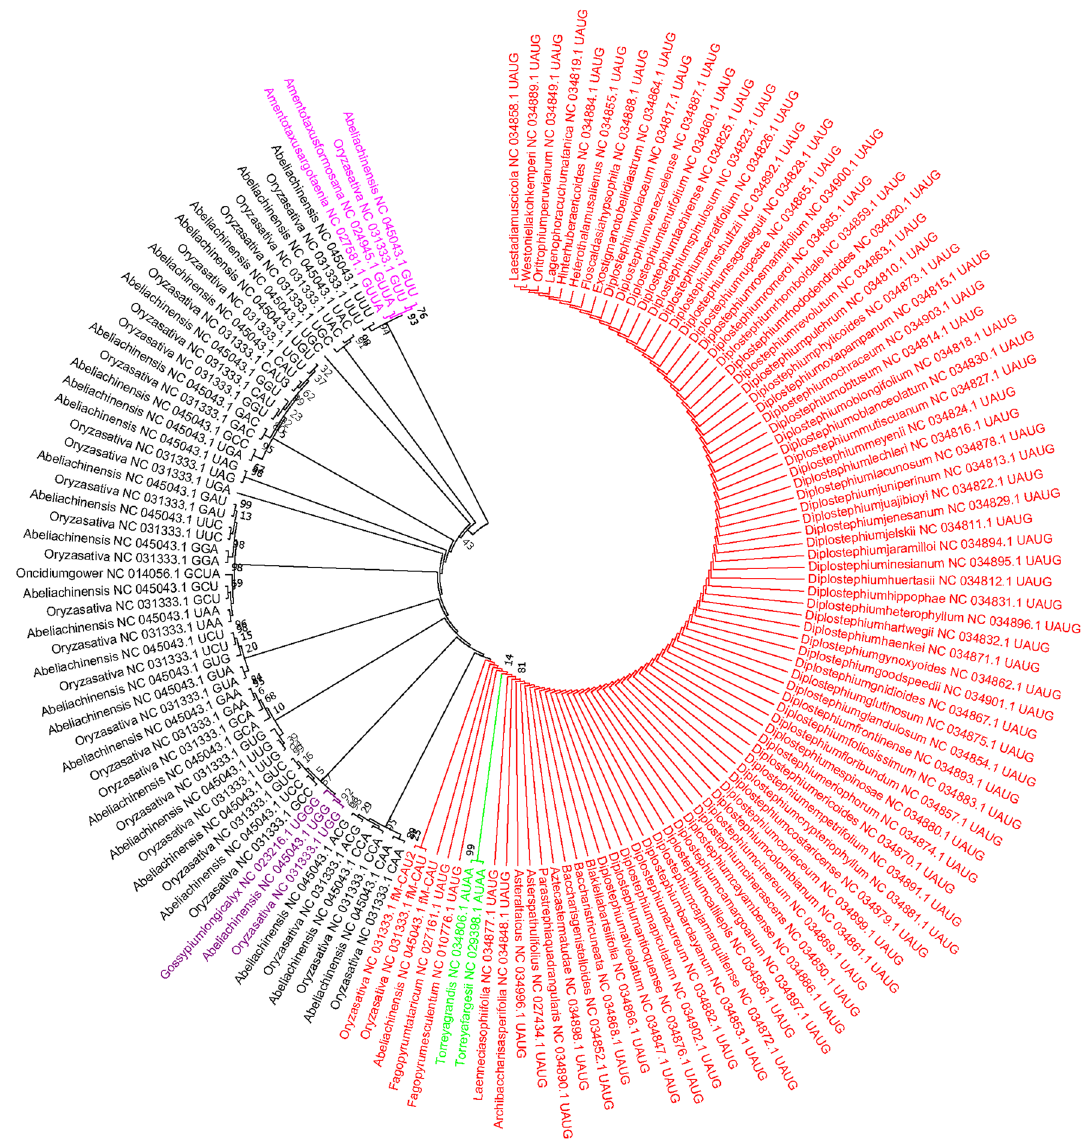
Figure 9. Phylogenetic tree of a putative quadruplet anticodon containing tRNAs with triplet codon– containing tRNAs. The phylogenetic grouping revealed that the quadruplet anticodons had evolved via the addition of a nucleotide preceding the third nucleotide of the triplet anticodons. The evolutionary history was inferred by using the Maximum Likelihood method based on the Tamura–Nei model. The tree with the highest log likelihood (−1053.93) is shown. Initial tree(s) for the heuristic search were obtained automatically by applying the Neighbor-Join and BioNJ algorithms to a matrix of pair-wise distances, estimated by using the Maximum Composite Likelihood (MCL) approach and then selecting the topology with the superior log likelihood value. The tree was drawn to scale, with branch lengths measured in the number of substitutions per site. The analysis involved 147 nucleotide sequences. All positions with less than 95% site coverage were eliminated; that is, fewer than 5% alignment gaps, missing data, and ambiguous bases were allowed at any position. There were a total of 26 positions in the final dataset. Evolutionary analyses were conducted using the MEGA